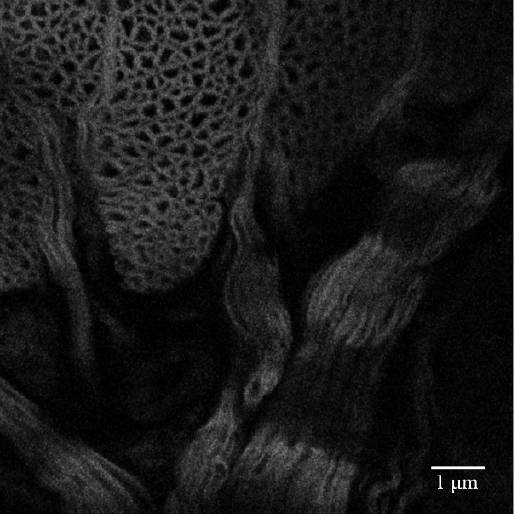
Figure 4. Image of the leech specimen at − 0.0415 mm in the z ‐ axis direction.